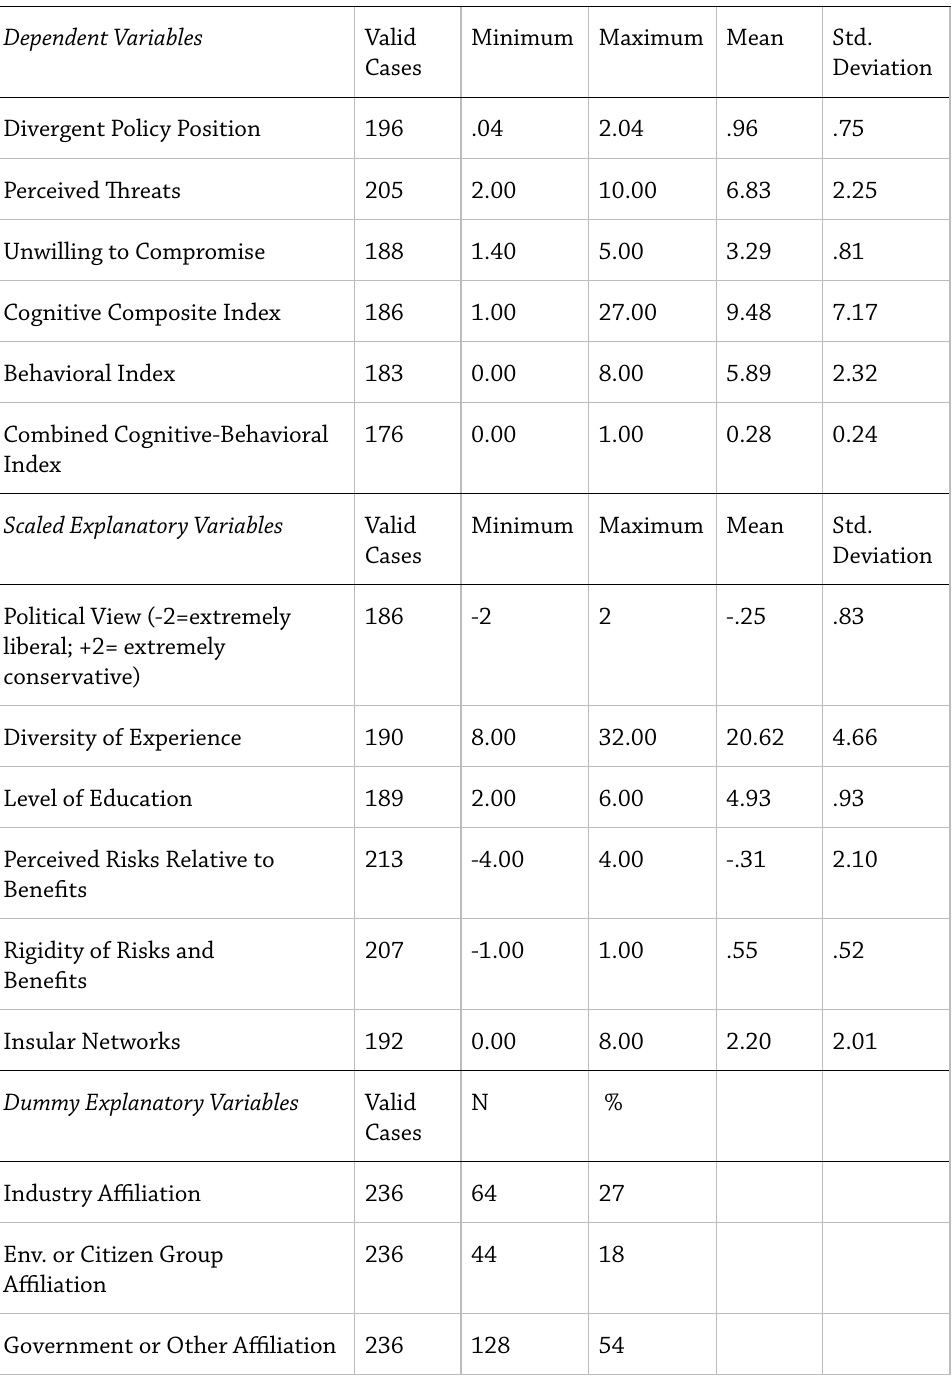
Table A2. Descriptive Statistics of Model